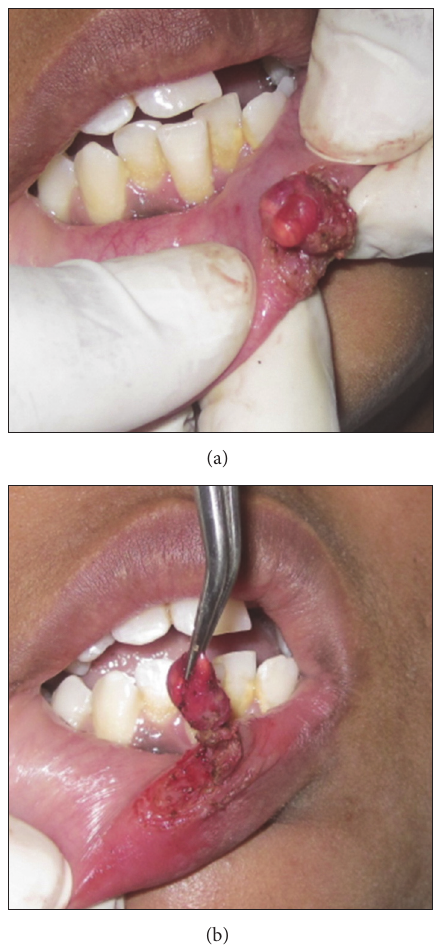
Figure 3: Intraoperative